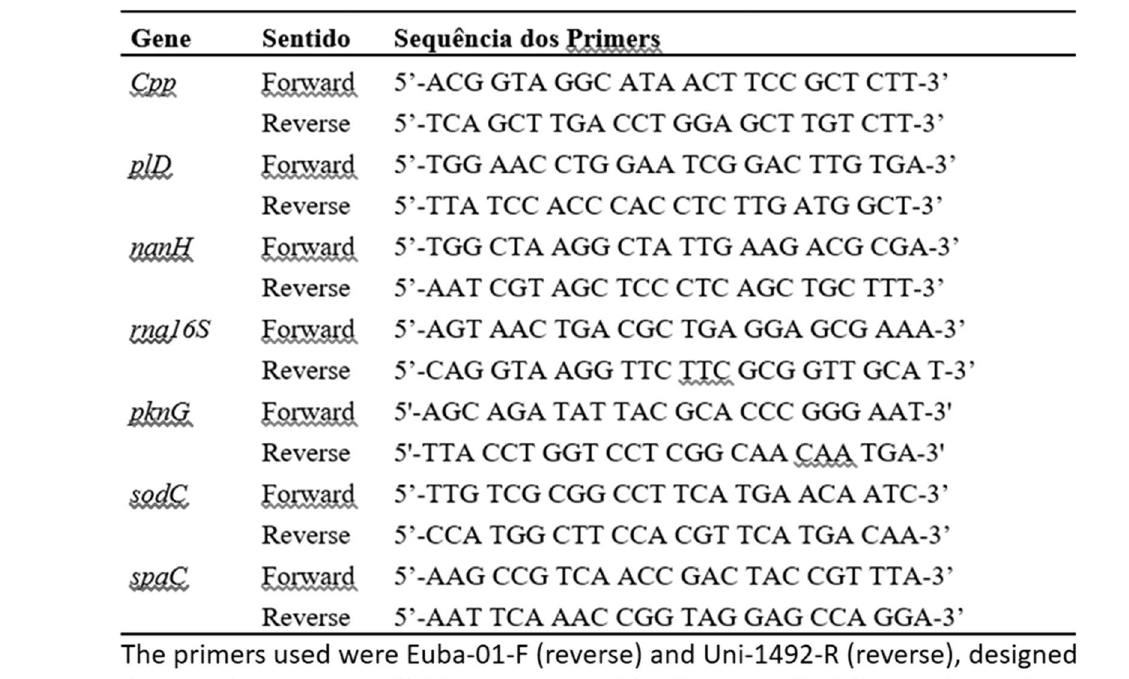
Fig. 1 Primers used in the